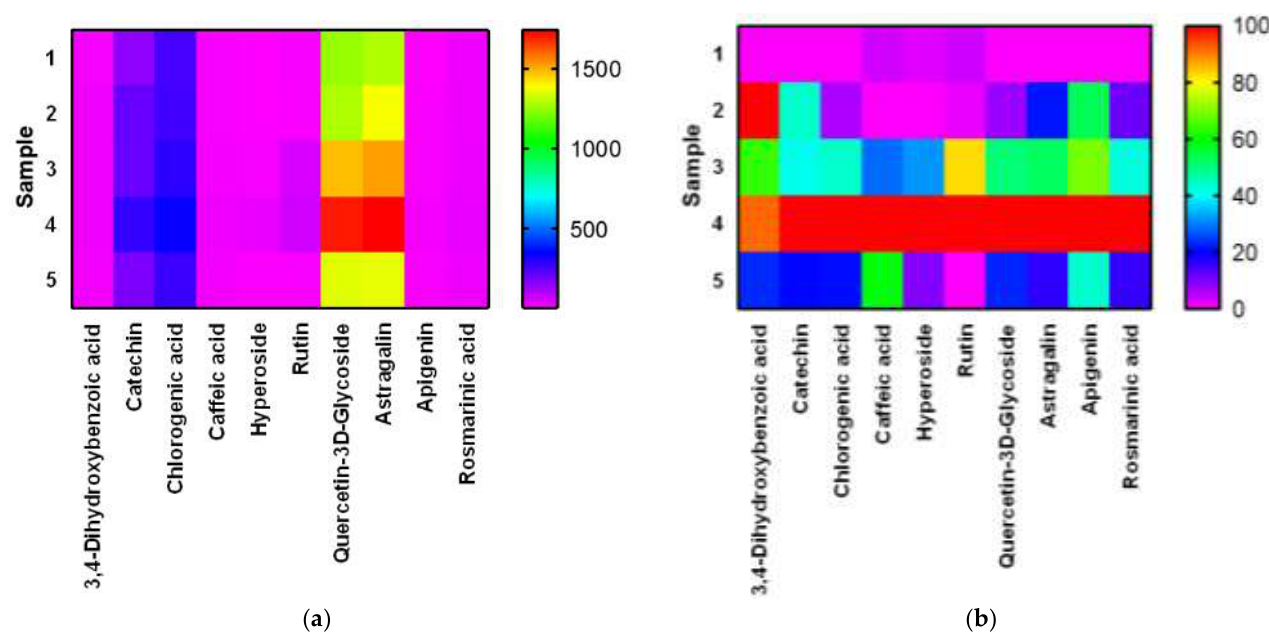
Figure 7. Heatmap for BAS content E. globulus extract with different extraction times (with US treatment): ( a ) — native data, ( b ) — after normalized.